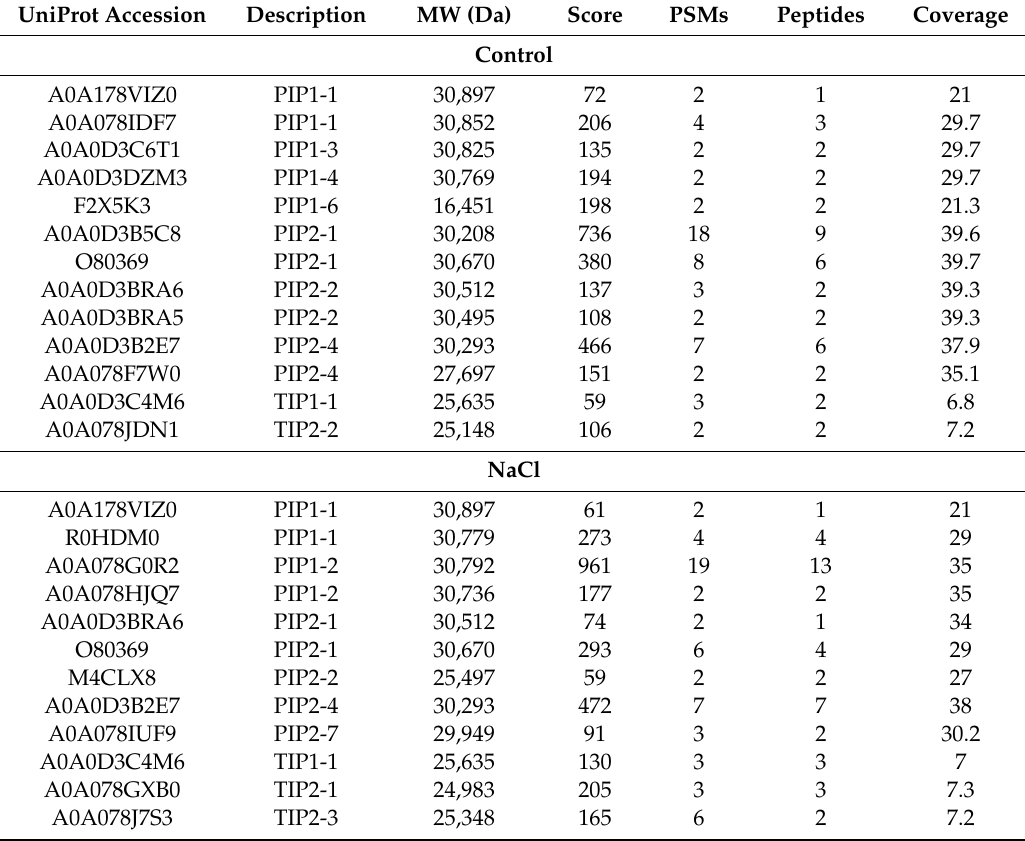
Table 2. Aquaporins identified in the control and NaCl detergent-resistant membranes (DRMs) after a database search. MW is molecular weight (in dalton), PSMs is the number of fragmentation spectra acquired, peptides is the number of distinct peptide sequences in the protein group and coverage is the percentage of the protein sequence covered by identified